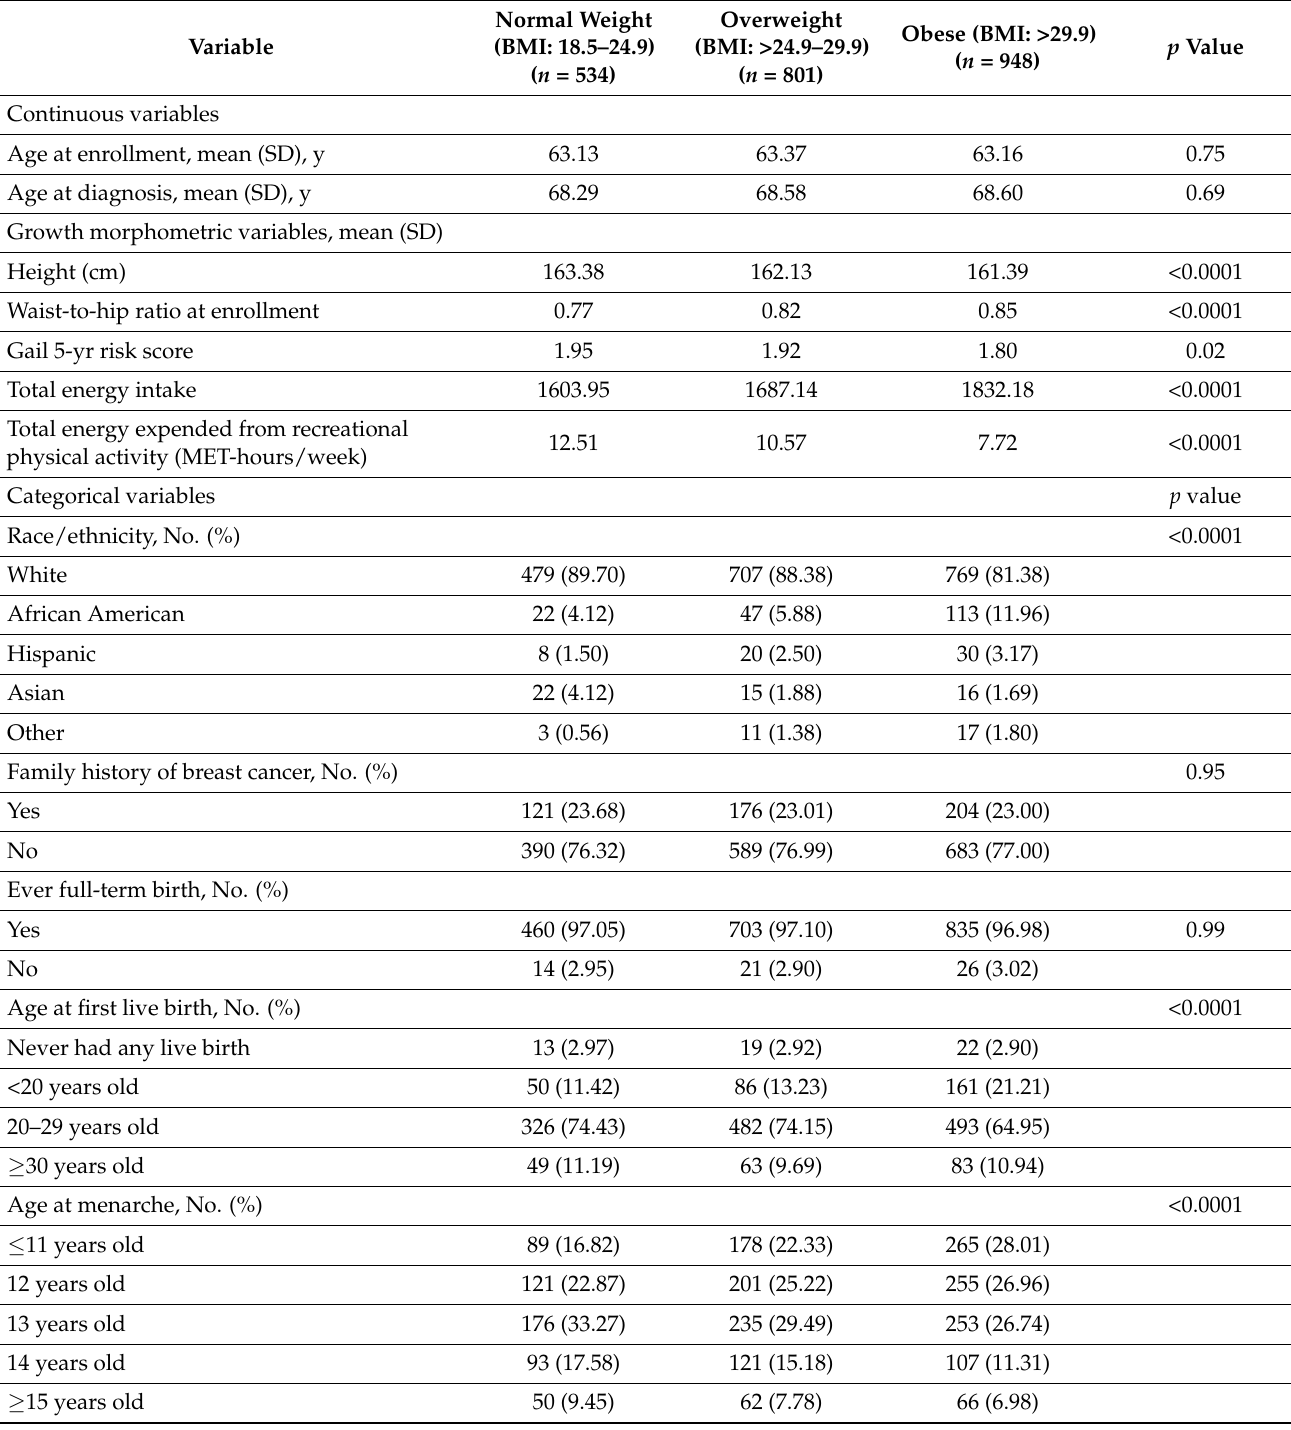
Table 2. Associations between BMI and